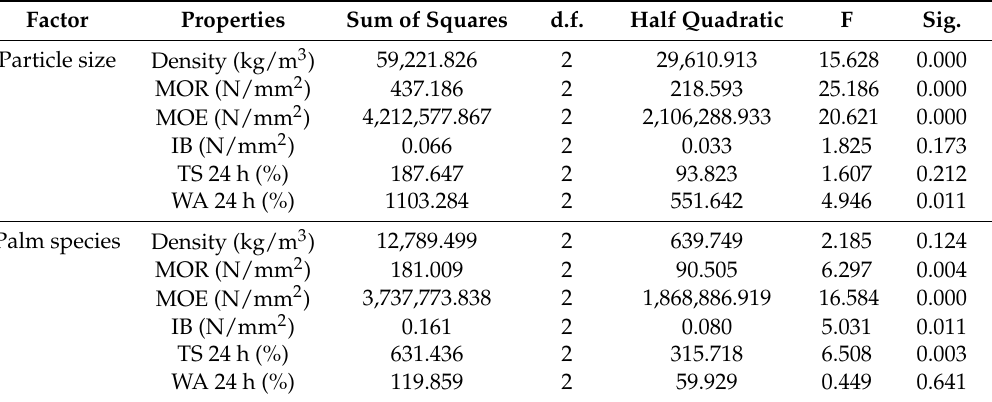
Table 8. ANOVA of the results of the